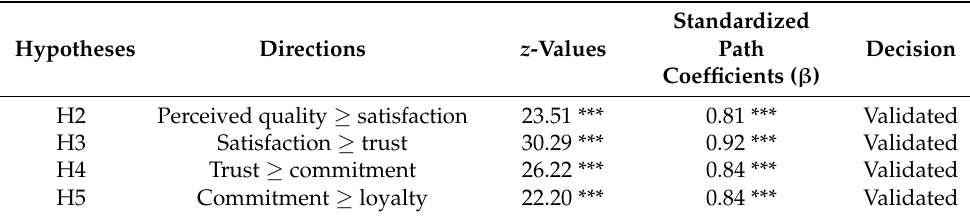
Table 3. Hypotheses testing in Rojas-M é ndez et al.’s (2009) model explaining loyalty by perceived quality ≥ satisfaction ≥ trust ≥ commitment ≥ loyalty.